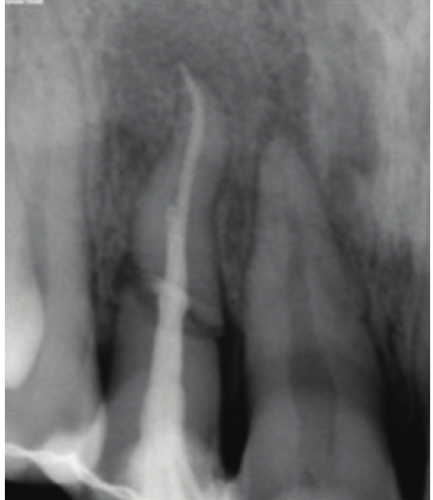
Figure 17: Obturation 12.